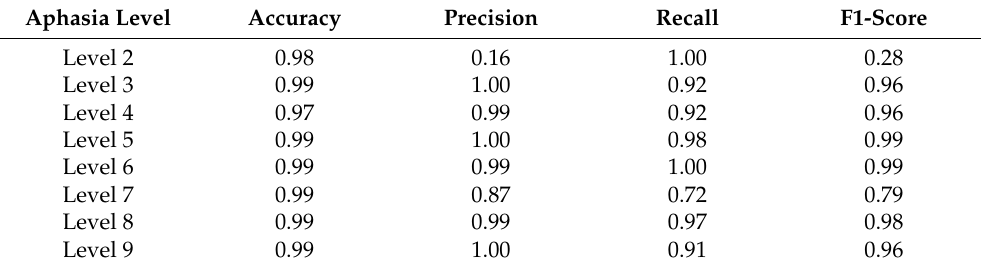
Table 15. Aphasia severity level classification report of KNN machine learning model using 10 s audio chunks and MFCC feature extractor.